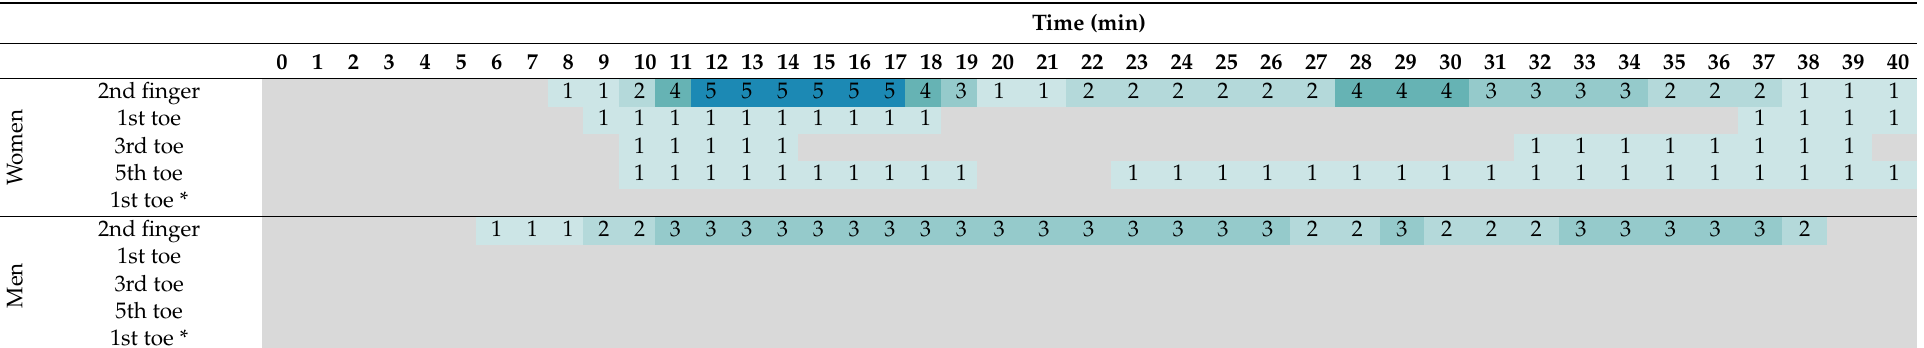
Table 3. Heat map presenting the number of participants that demonstrated a CIVD reaction for each minute of the cold immersion during exposure in the thermoneutral environment (23 ± 1 ◦ C). Colors indicate frequencies. Gray color indicates lack of